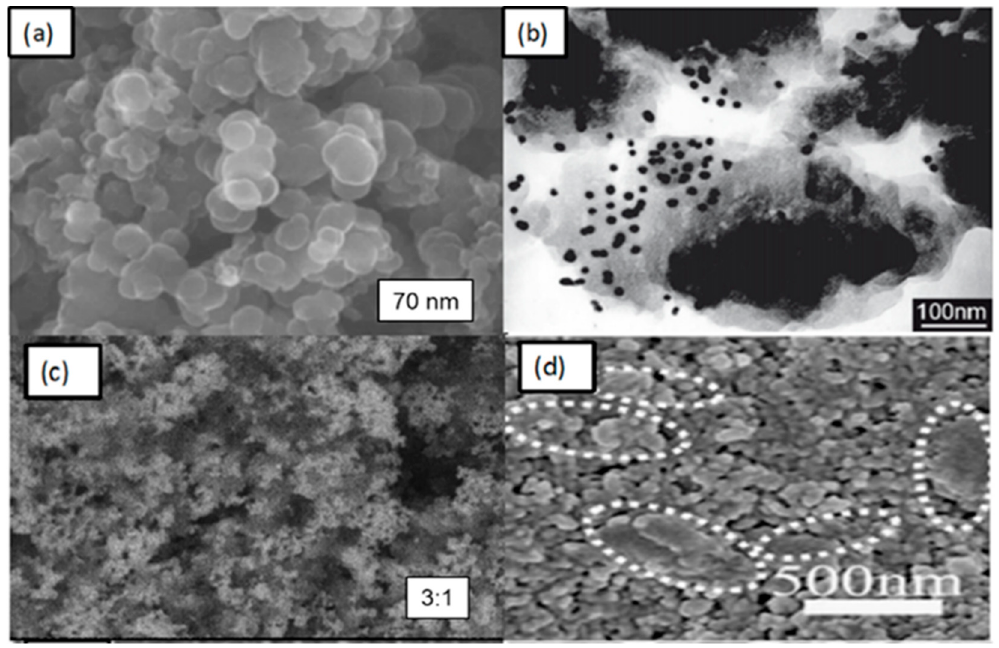
Figure 7. SEM morphologies of ( a ) CB and CB with different hybridizations, including ( b ) CB + Pt, ( c ) CB + TiN, ( d ) CB + Gr. Reprinted with permission from References [51,63–65].